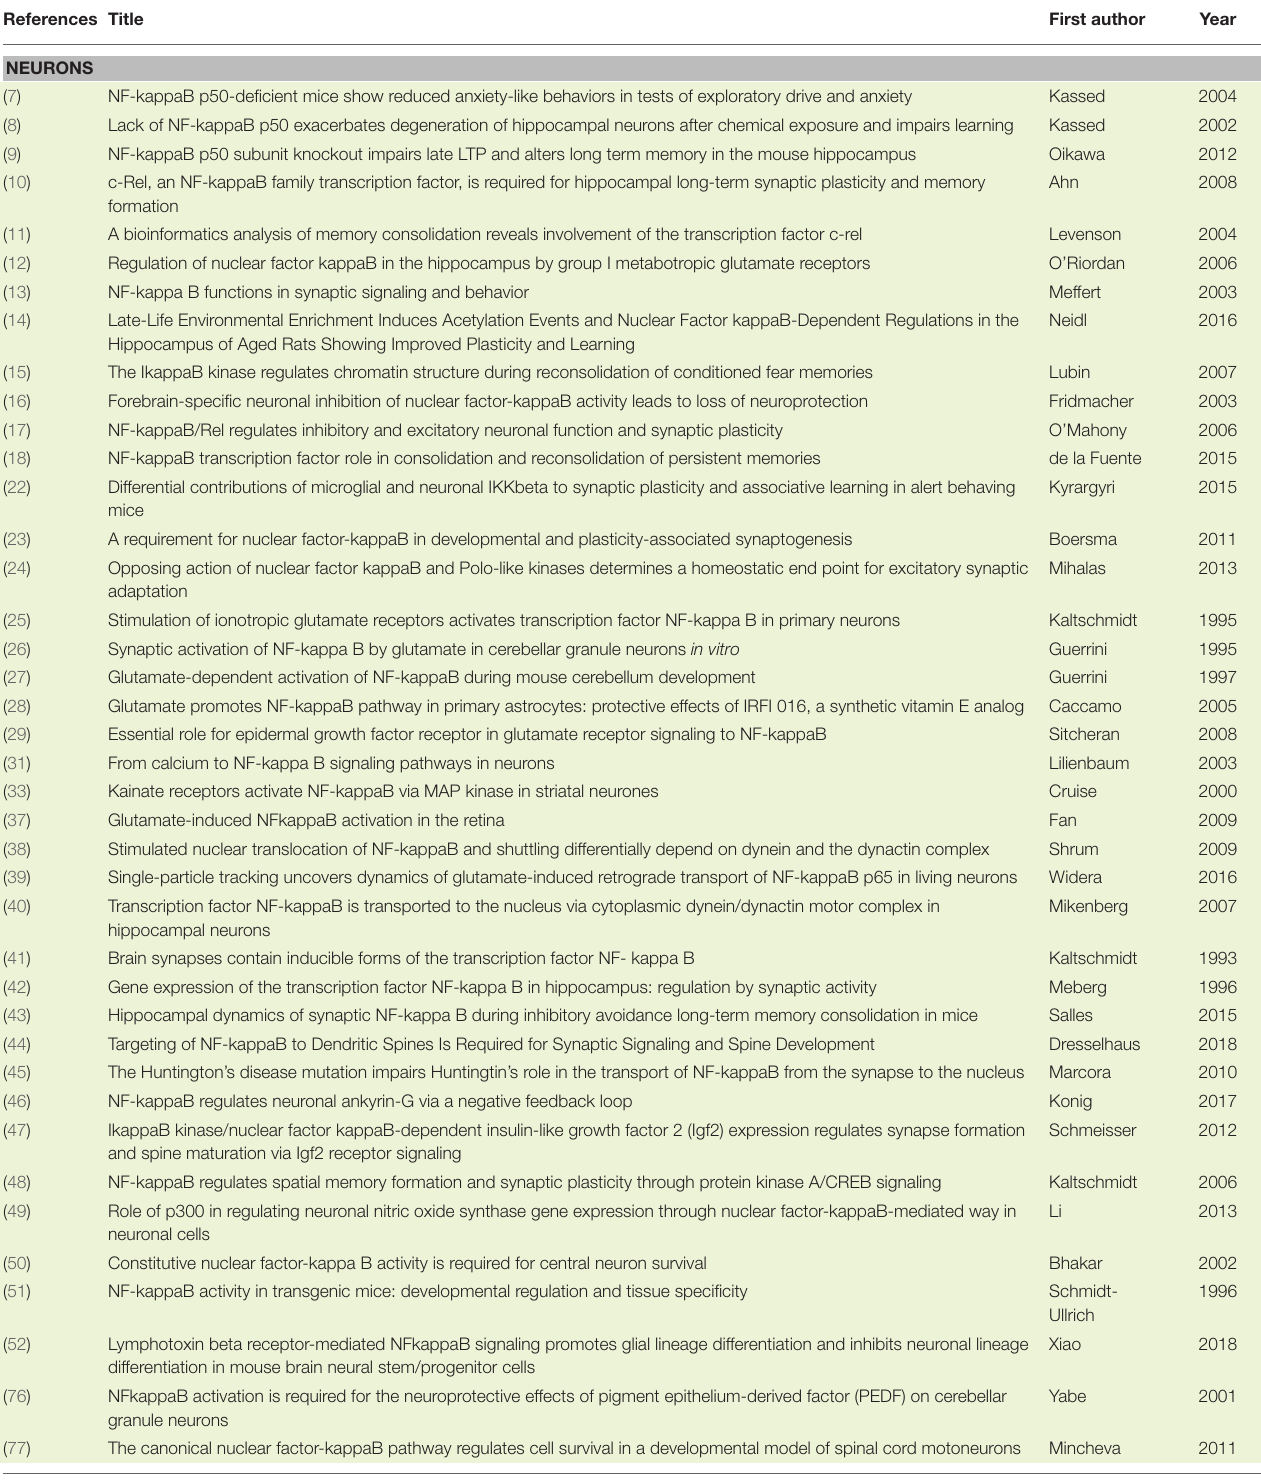
TABLE 2 | A reference categorizing primary literature cited in this review according to the specificity of the brain cell type in which NF- κ B is investigated: neurons, microglia, or